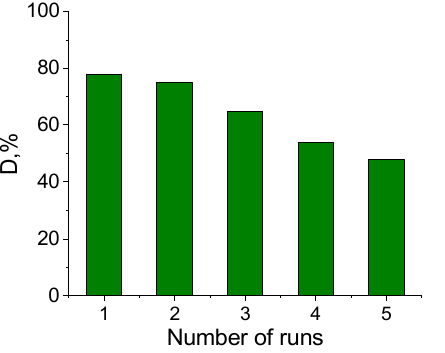
Figure 7. Efficiency of Ni@Au 0.01 M in 5 sequential cycles of reduction of 4-nitrophenol.